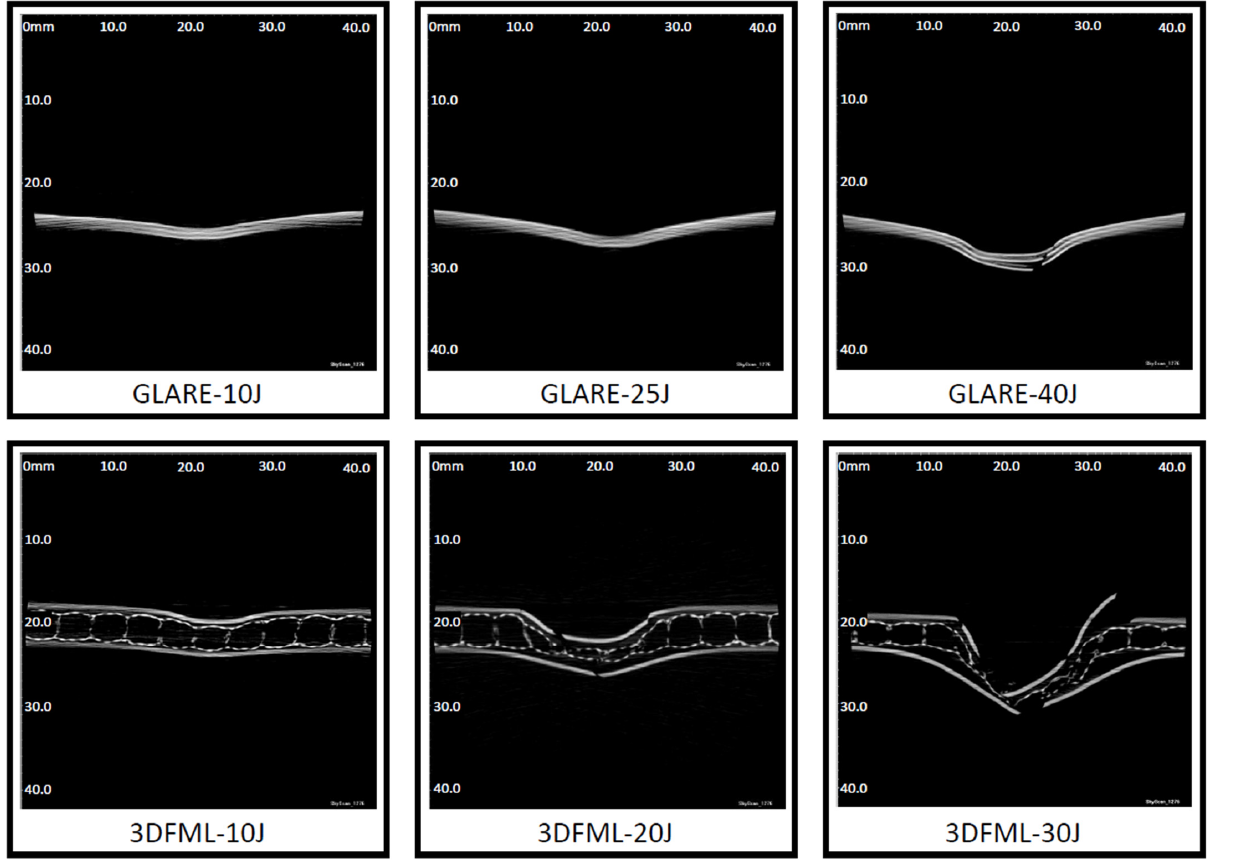
Figure 11. Micro-CT images of impacted